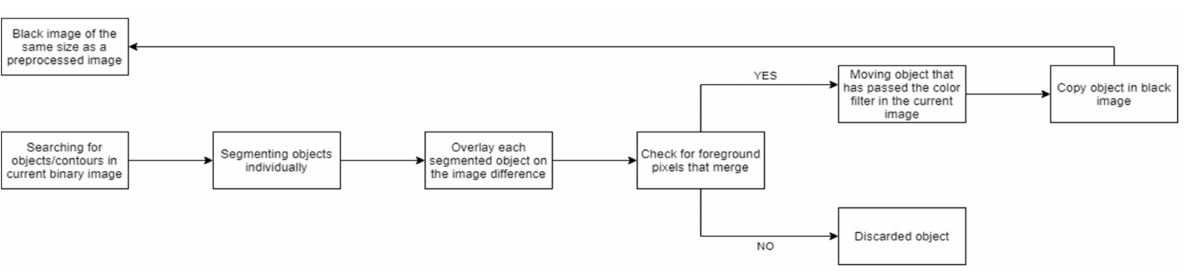
Figure 5. Block diagram of the pseudocode for checking the regions of the current image to which moving pixels